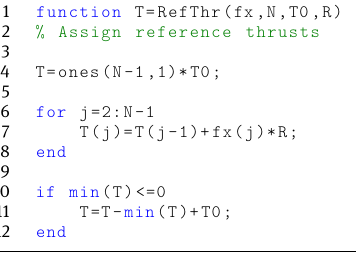
Figure 6: Evaluation of positive reference thrusts that fulfill the horizontal equilibrium equations.